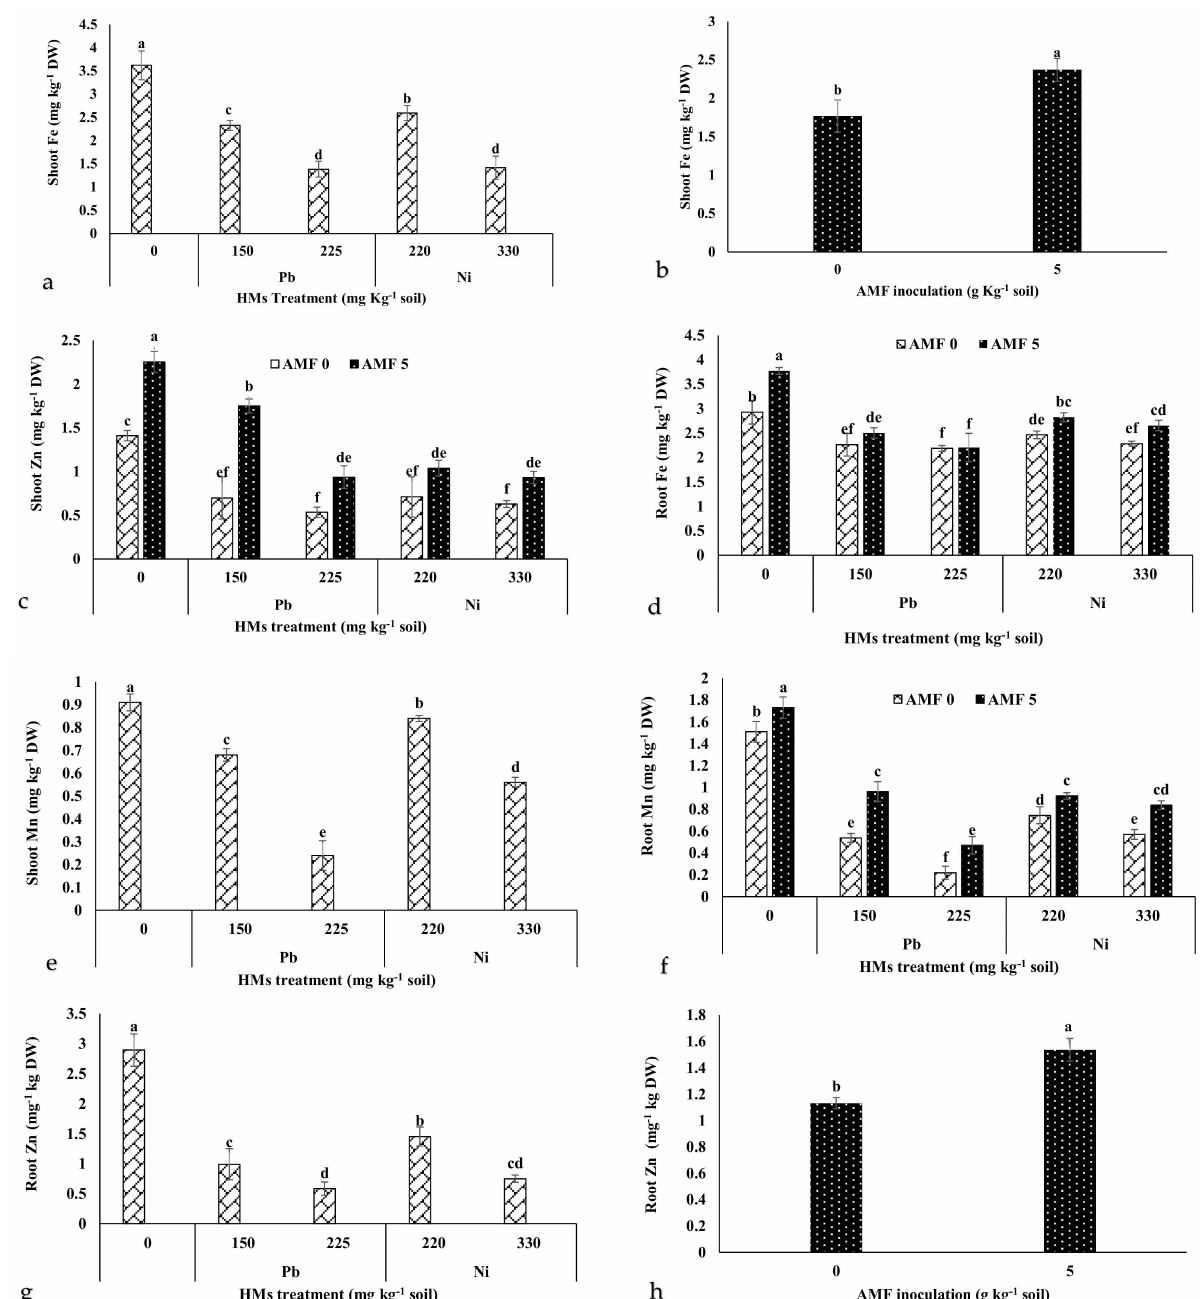
Figure 5. The effect of arbuscular mycorrhizal fungi (AMF) inoculation and Pb and Ni (mg kg − 1 soil) heavy metal (HM) stress interactions and/or independent effects on shoot Fe content ( a , b ), shoot Zn ( c ), root Fe ( d ), shoot and root Mn ( e , f ) as well as root Zn ( g , h ) content in lavender plants. Different letters indicate significant differences according to the LSD test at p <